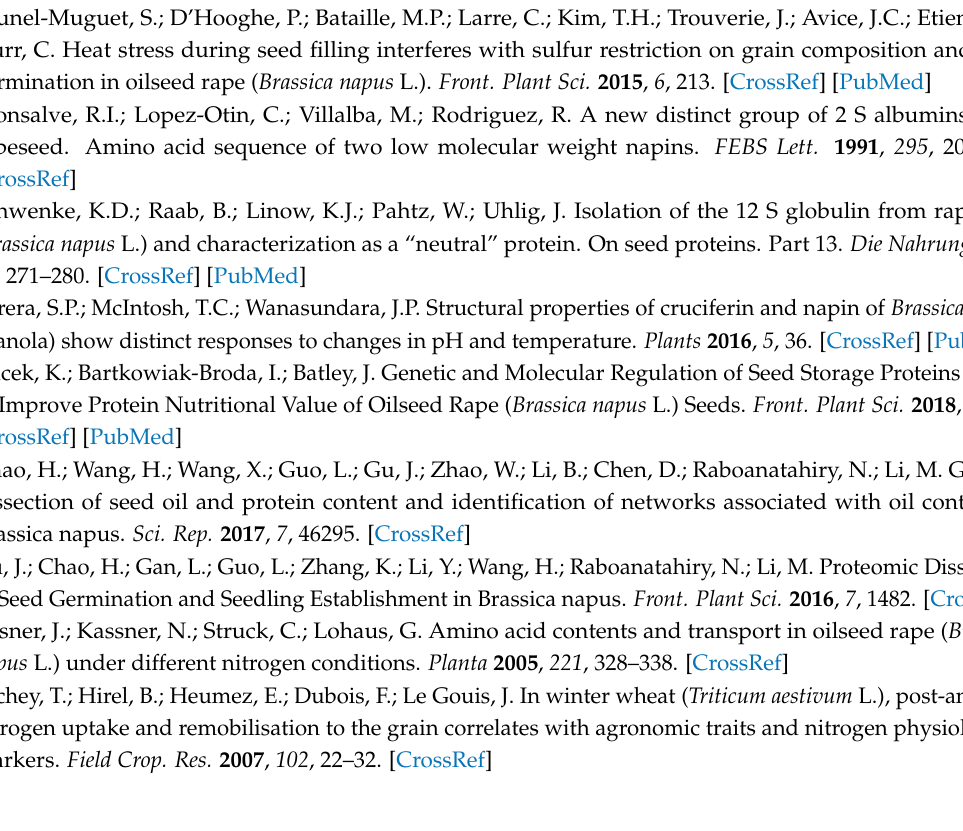
N-starved Arabidopsis plants; Supplementary Figure S5: Schematic drawing of promoter regions of OSR NAPIN and OSR CRUCIFERIN; Supplementary Table S1: Hydroponic media N-starvation A. thaliana ; Supplementary Table S2: Hydroponic media N-starvation B. napus ; Table S3: Cis elements identified in upstream regions of OSR CRUCIFERIN; Supplementary Table S4: AGI codes and description of SSP associated transcripts in A. thaliana ; Supplementary Table S5: Cis elements identified in upstream regions of OSR NAPIN